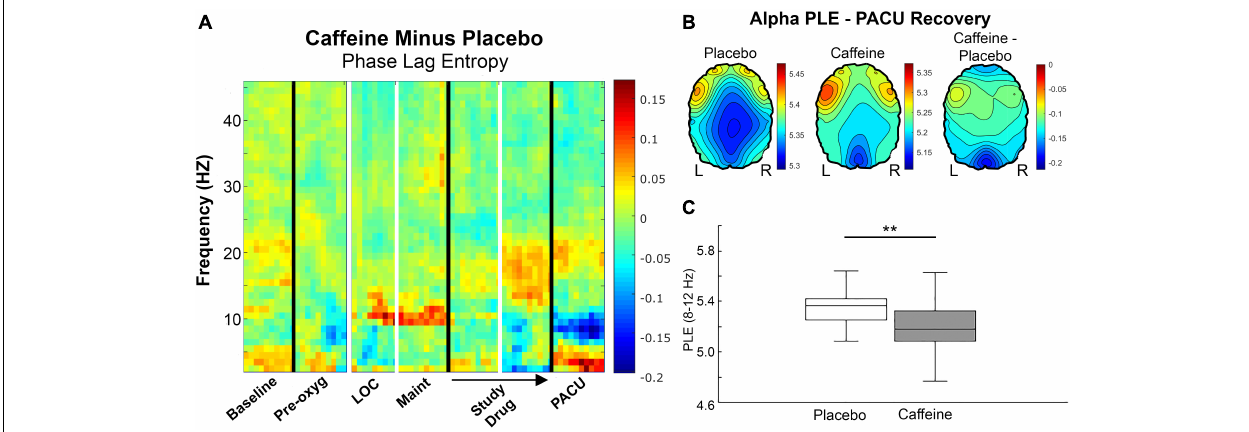
FIGURE 6 | (A) Phase lag entropy presented for participants randomized to placebo ( n = 27) subtracted from those randomized to caffeine ( n = 28) across bandwidths and epochs. Alpha (8 – 12 Hz) appears reduced with caffeine during postanesthesia care unit recovery (blue shading). Color bars represent median phase lag entropy differences between groups. (B) The anterior-posterior alpha phase lag entropy gradient appears diminished in the placebo group compared to caffeine during PACU recovery, and alpha phase lag entropy appears particularly reduced posteriorly in the caffeine group. Color bars represent median phase lag entropy for the left and middle panels and median difference between groups in the right panel. (C) Overall, alpha phase lag entropy is relatively lower in the caffeine group [5.18 (5.09 – 5.23)] compared to placebo [5.37 (5.25 – 5.42); p = 0.005] during PACU recovery. Pre-oxy, pre-oxygenation; LOC, loss of consciousness; Maint, maintenance anesthesia phase; PACU, postanesthesia care unit; PLE, phase lag